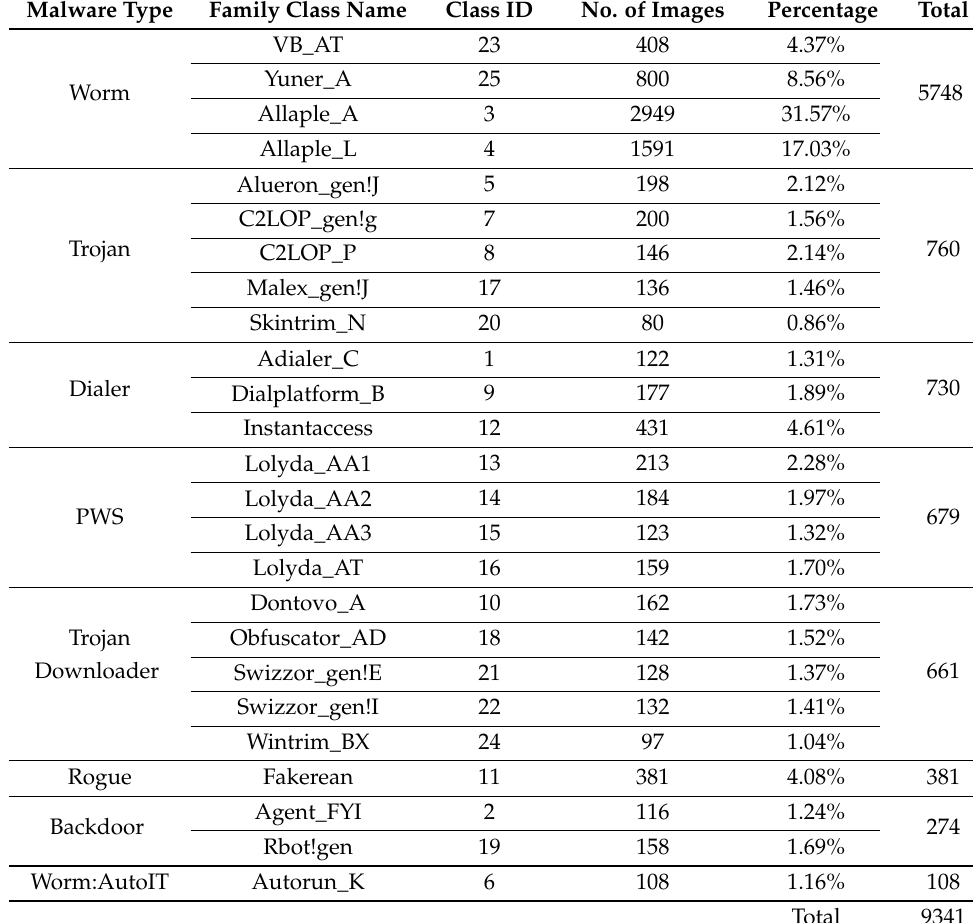
Figure 4. A sample of malware binary file sections and their corresponding fragments in the visualized version. Table 5. The distribution of malware families among Malimg